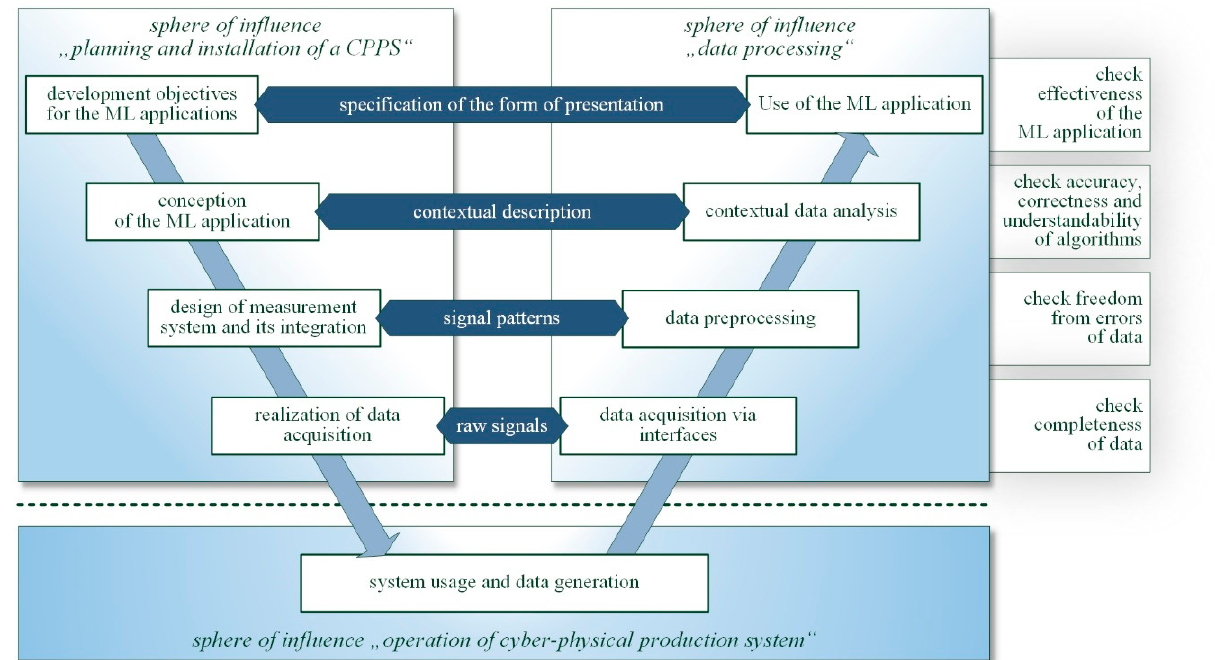
Figure 3. Concept—V-Model for Data Quality Assurance in ML Applications for CPPS.